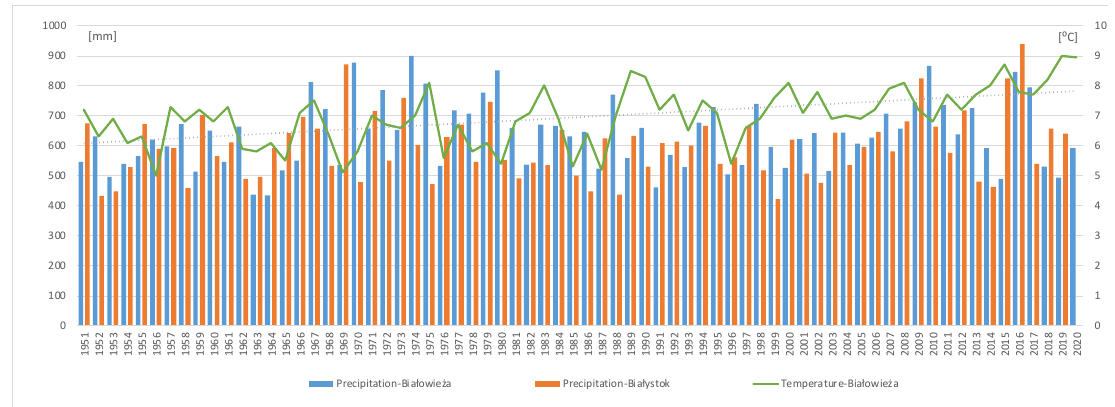
Figure 4. Precipitation and mean air temperature in the Narewka catchment area in the period 1951–2020.